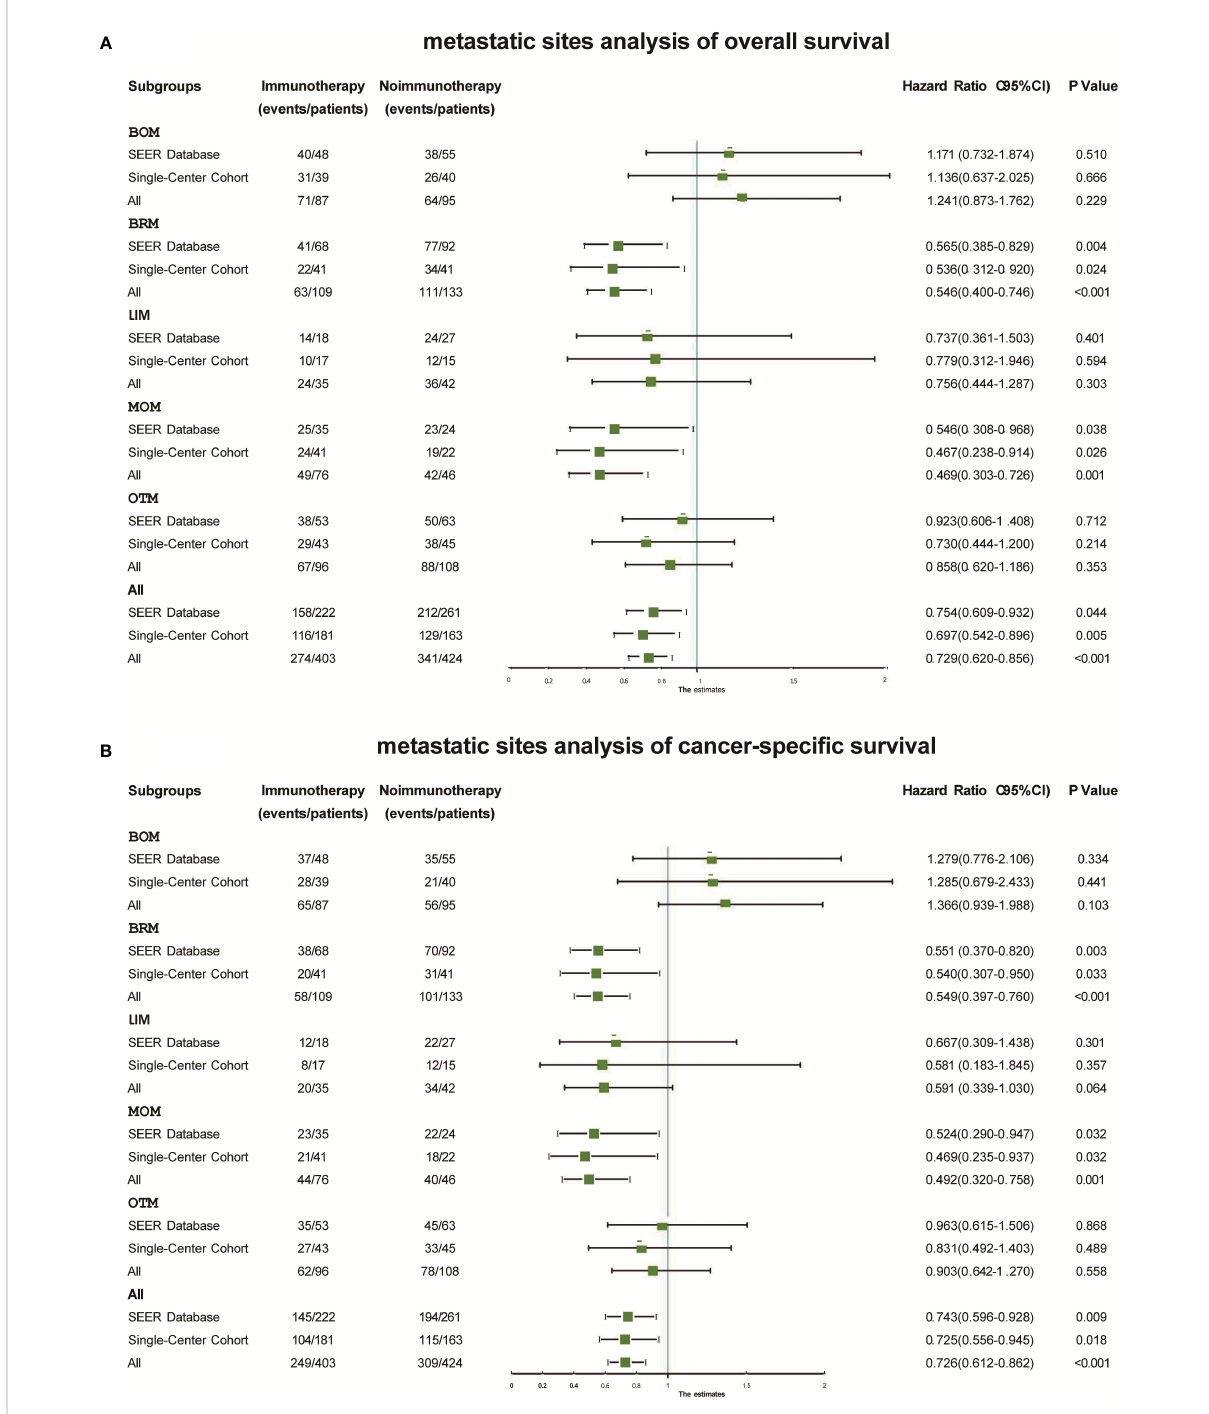
FIGURE 3 Forest plots displaying the relationship between immunotherapy and overall survival (A) and cancer-speci fi c survival (B) within different subgroups in each cohort. BOM, bone metastases only; BRM, brain metastases only; CSS, cancer-speci fi c survival; LIM, liver metastases only; MOM, multiple organ metastases; OS, overall survival; OTM, other